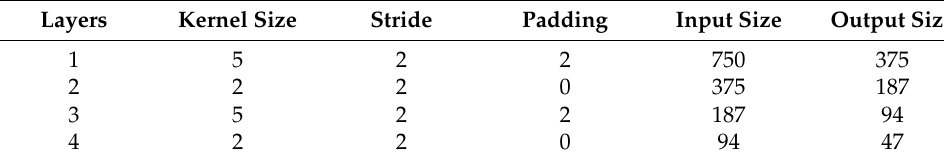
Table 1. Values of parameters for proposed 1-D CNN